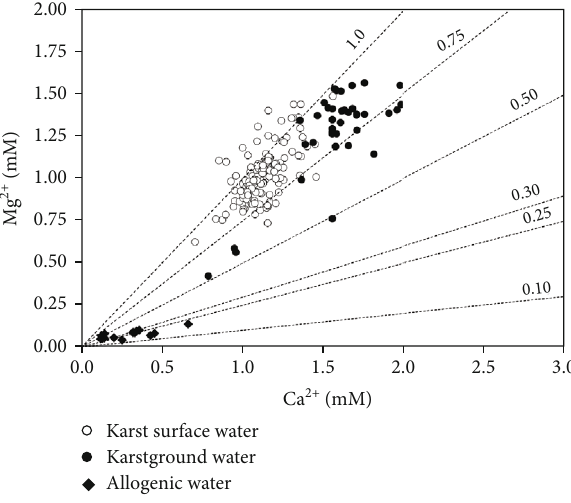
Figure 8: Molar concentration between Mg 2+ and Ca 2+ of the surface and underground waters in Shanmuhe